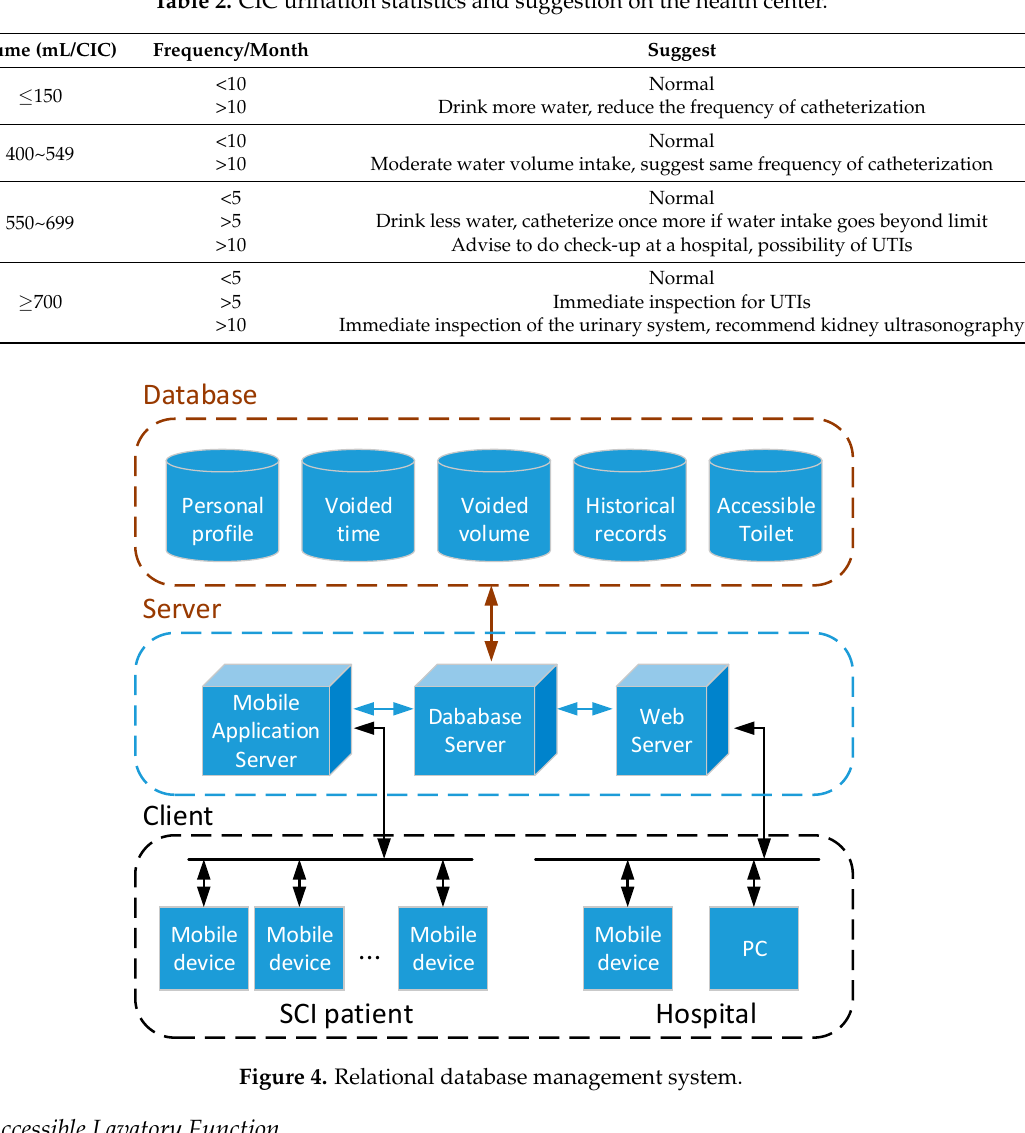
Table 2. CIC urination statistics and suggestion on the health center.